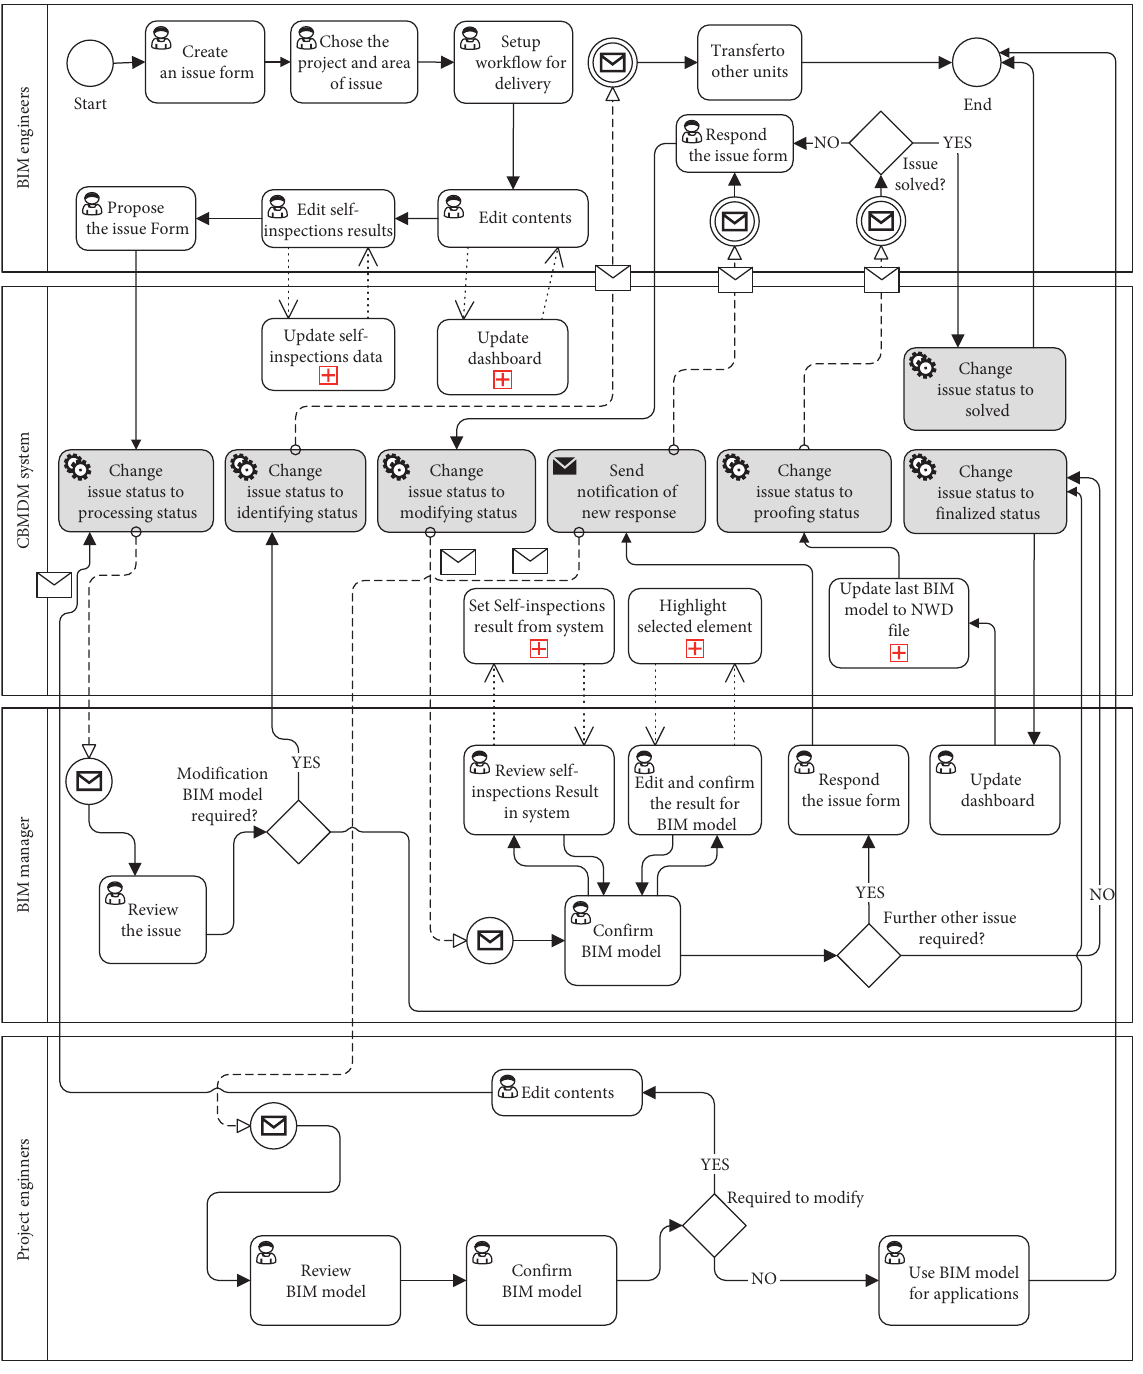
Figure 5: The system process flowchart used in the CBMDM